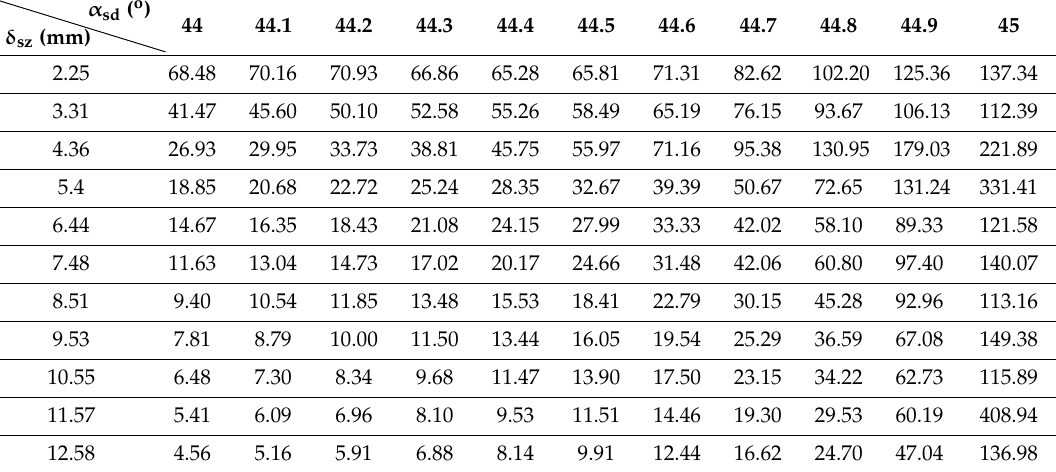
Table 3. List of ratios between useful torque and cogging torque in the DCPM motor being tested for full rotor revolution.